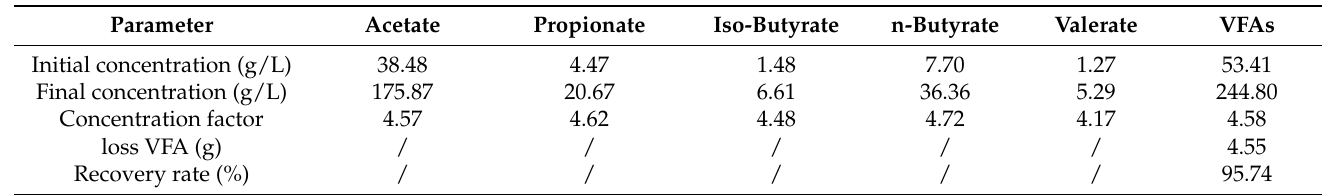
Table 2. Concentration result of the forward osmosis membrane.